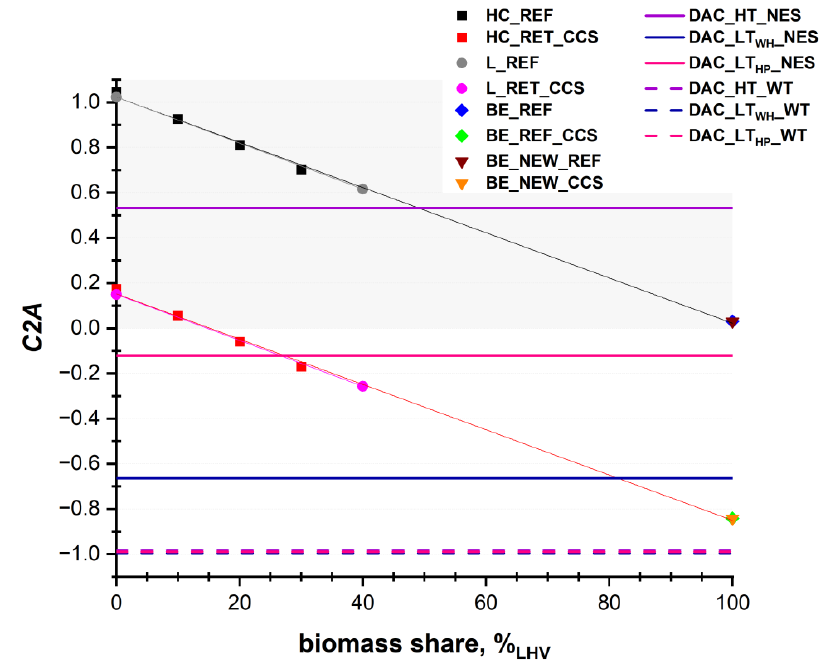
Figure 6. Carbon to Atmosphere Factor for the analyzed cases and scenarios. As marked in Figure 6, the processes in the grey area have a C2A of above 0, which means that they lead to no mitigation, or even to an increase in emissions, or have a po- tential for emissions reduction (when compared with reference plants). If the electricity for the DAC installations comes from wind turbines (WT), their potential can be fully uti- lized. However, when the electricity is supplied from a highly carbonized national energy system (like in the case of Poland), their effect is significantly reduced and in some cases can actually add additional emissions to the atmosphere. 3.3. Thermo-Ecological Cost of Negative Emissions In Table 7, the specific thermo-ecological cost of net electricity production for the an- alyzed power plants is presented. As can be noticed, with the increase in the biomass in the fuel input, the TEC decreases. On the other hand, CCS installation adds around 30% to 50% in terms of the depletion of non-renewable natural resources per unit of net elec- tricity production.